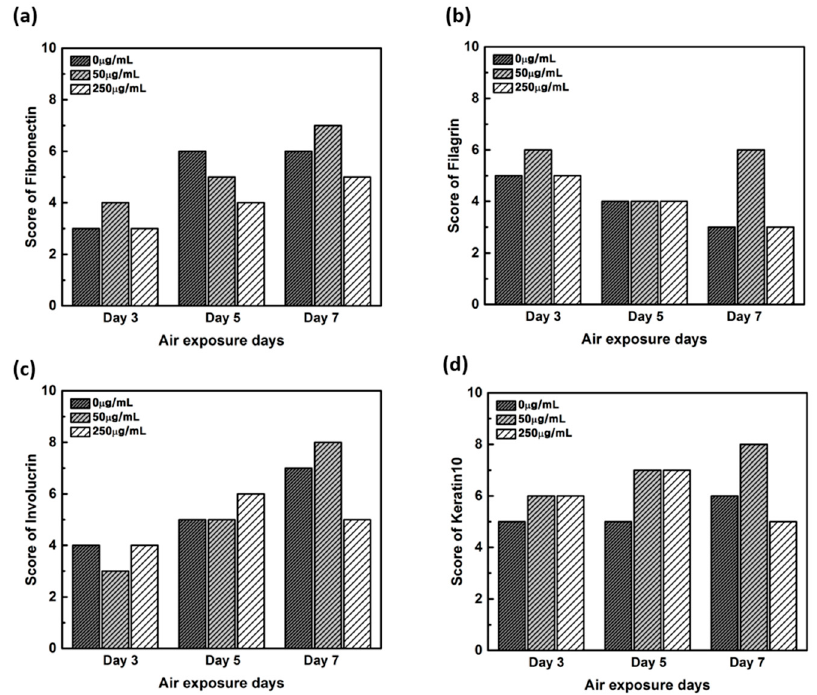
Figure 8. Quantitative analysis of the protein expression using the scoring method on the immunohistochemistry stained images. ( a ) Fibronectin, ( b ) filaggrin, ( c ) involucrin, and ( d )